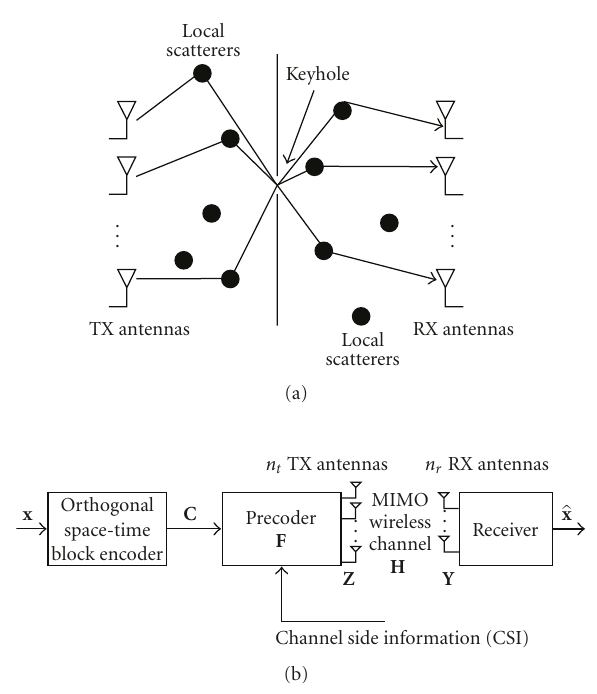
Figure 1: (a) Keyhole MIMO channel, (b) Block diagram of the system under